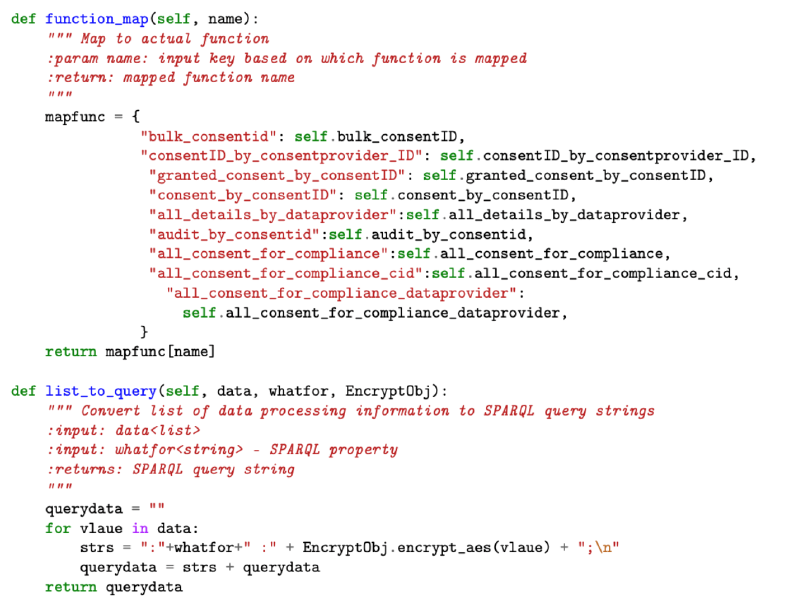
Figure 9. Sample code snapshot of the helper component of shared service